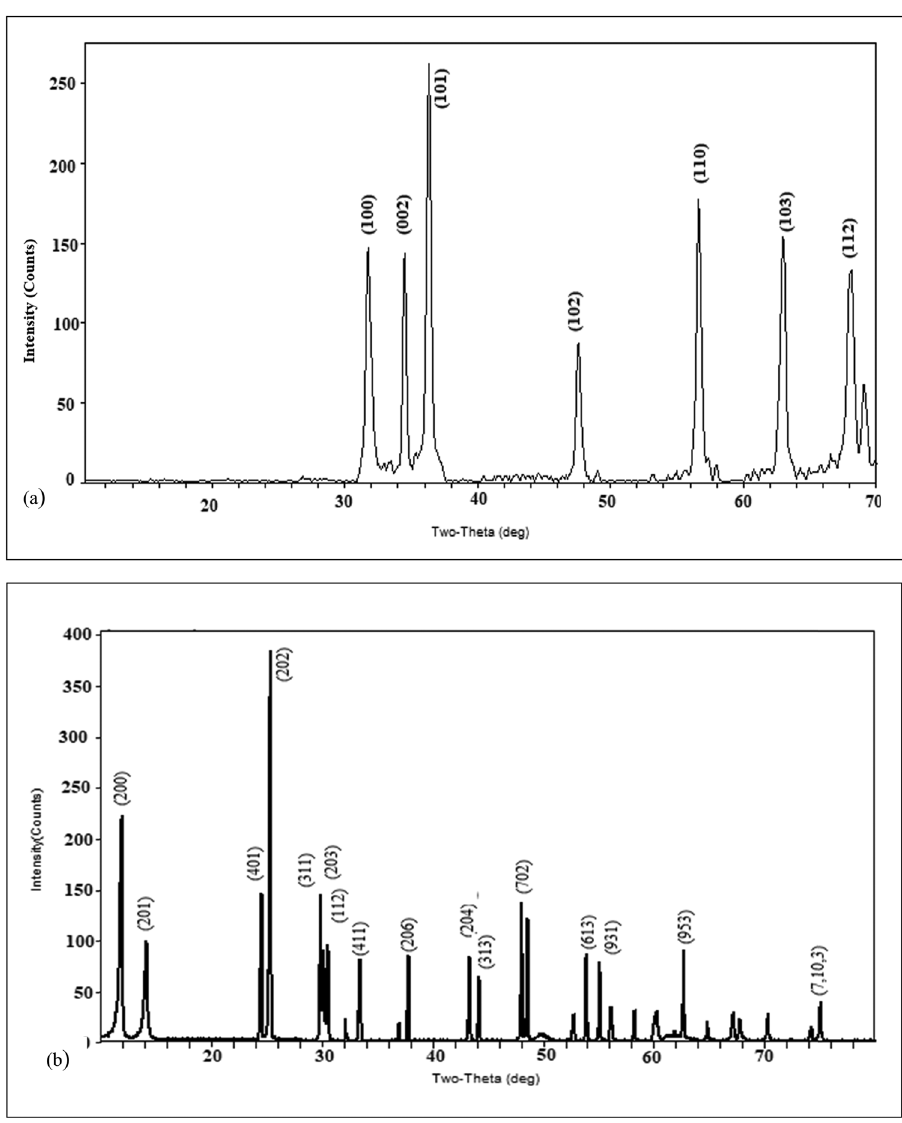
Figure 4: X - Ray di ff raction: ( a ) ZnO NSs spectrum; ( b ) NTO